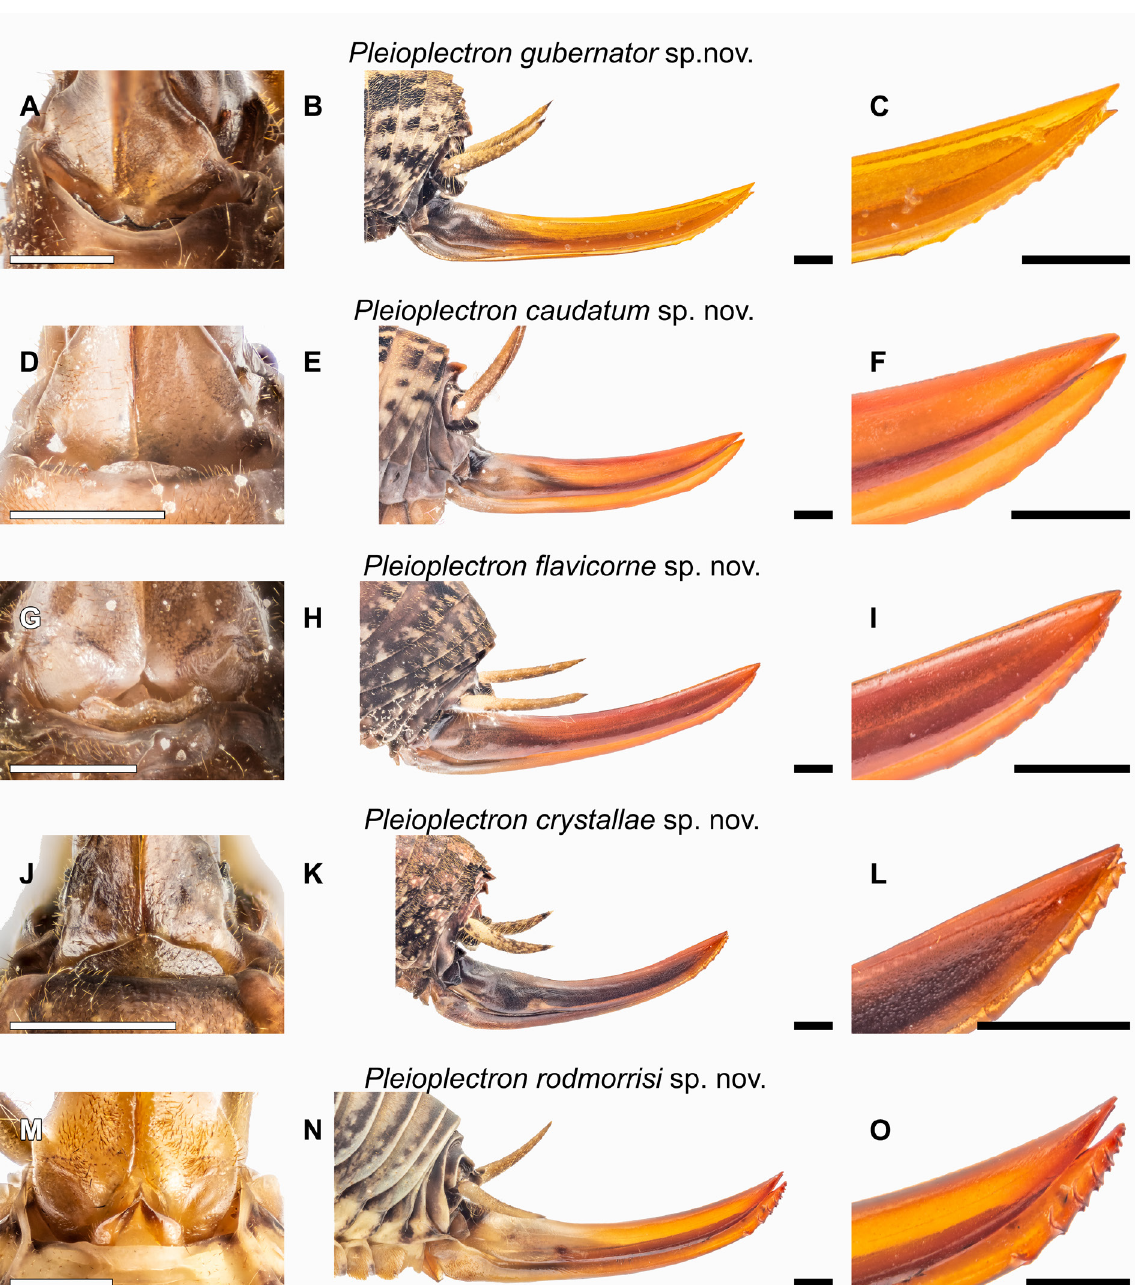
Fig. 11. Adult female terminalia of cave wētā in the genus Pleioplectron Hutton, 1896. Left column: subgenital plate; central and right columns: ovipositor. A–C . P. gubernator sp. nov. A . Awapoto Hut, Abel Tasman NP (MPN CW4057). B–C . Lewis Pass (MPN CW4071). D–F . P. caudatum sp. nov., Brewster Hut Track, Haast Pass (MPN CW4040). G–I . P. flavicorne sp. nov., Brewster Hut Track, Haast Pass (MPN CW4042). J–L . P. crystallae sp. nov., Cave Brook, Gouland Downs, Heaphy Track. J . MPN CW3993. K–L . MPN CW3990. M–O . P. rodmorrisi sp. nov., Hodder River, Inland Kaikōura Range (MPN CW3822). Scale bars = 1